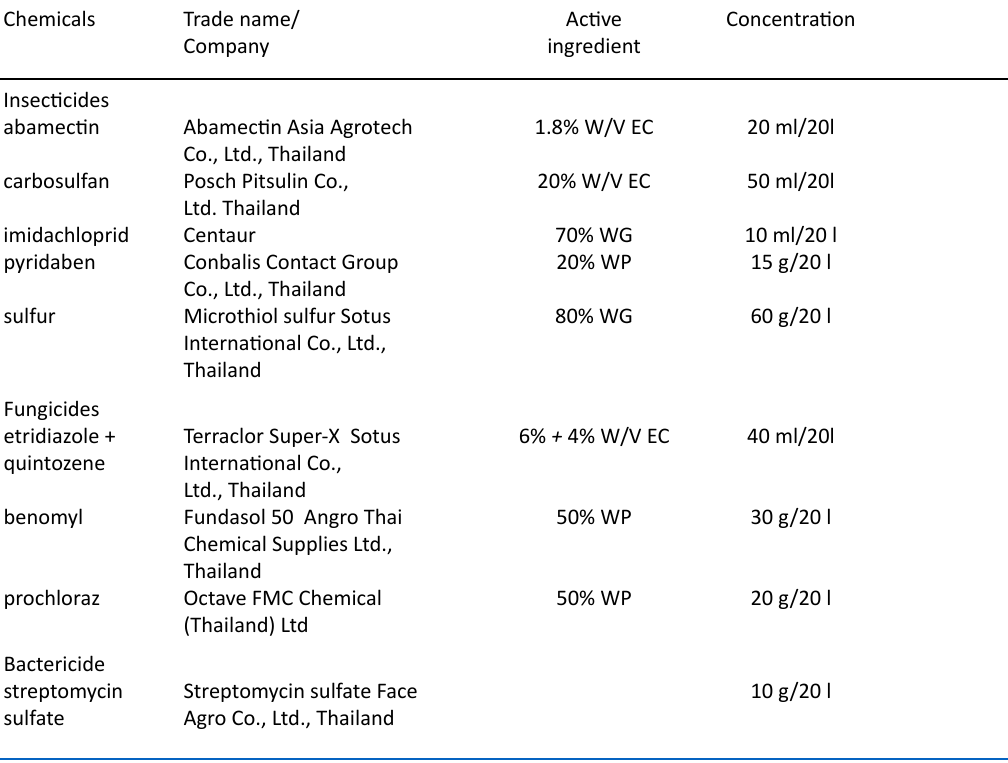
table 1. Pesticides used to study compatibility with B.pumilus FDKF5 and Bacillus sp. IKM1